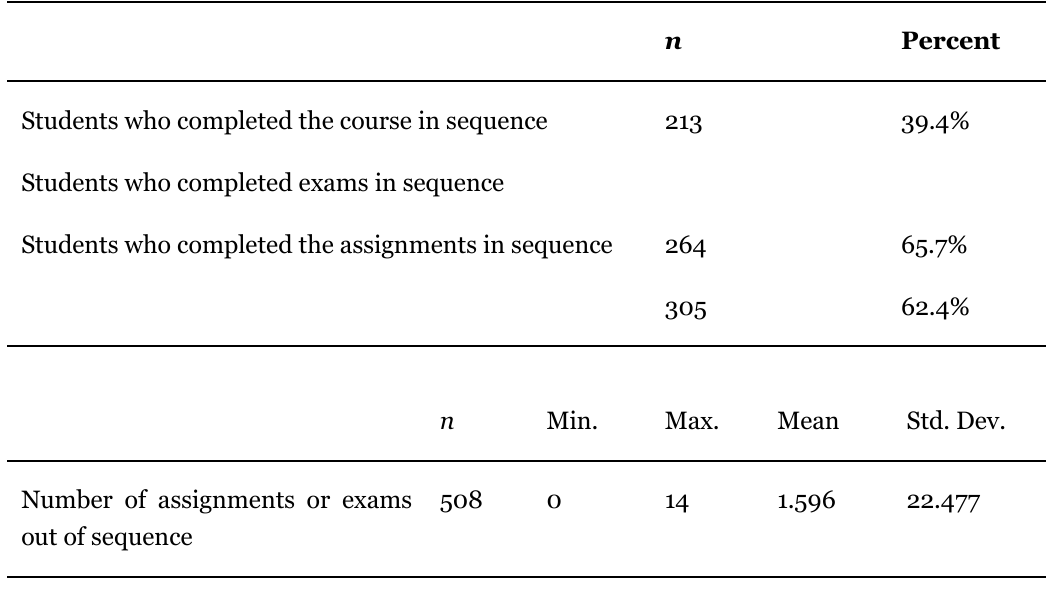
Sequential Movement Descriptive Statistics